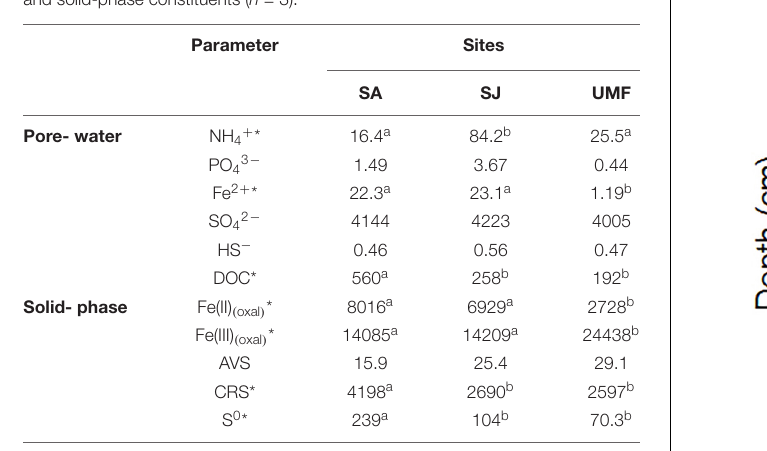
TABLE 2 | Depth-integrated inventories (mmol m − 2 ) of pore-water constituents and solid-phase constituents ( n = 3).